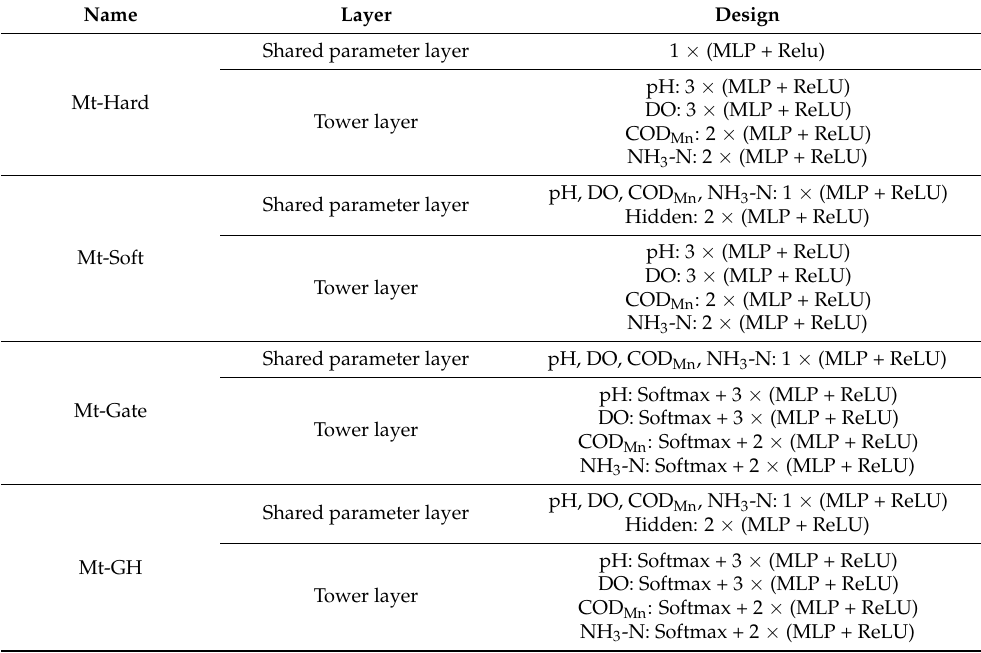
Table 1. The structure of the proposed four water quality prediction models.